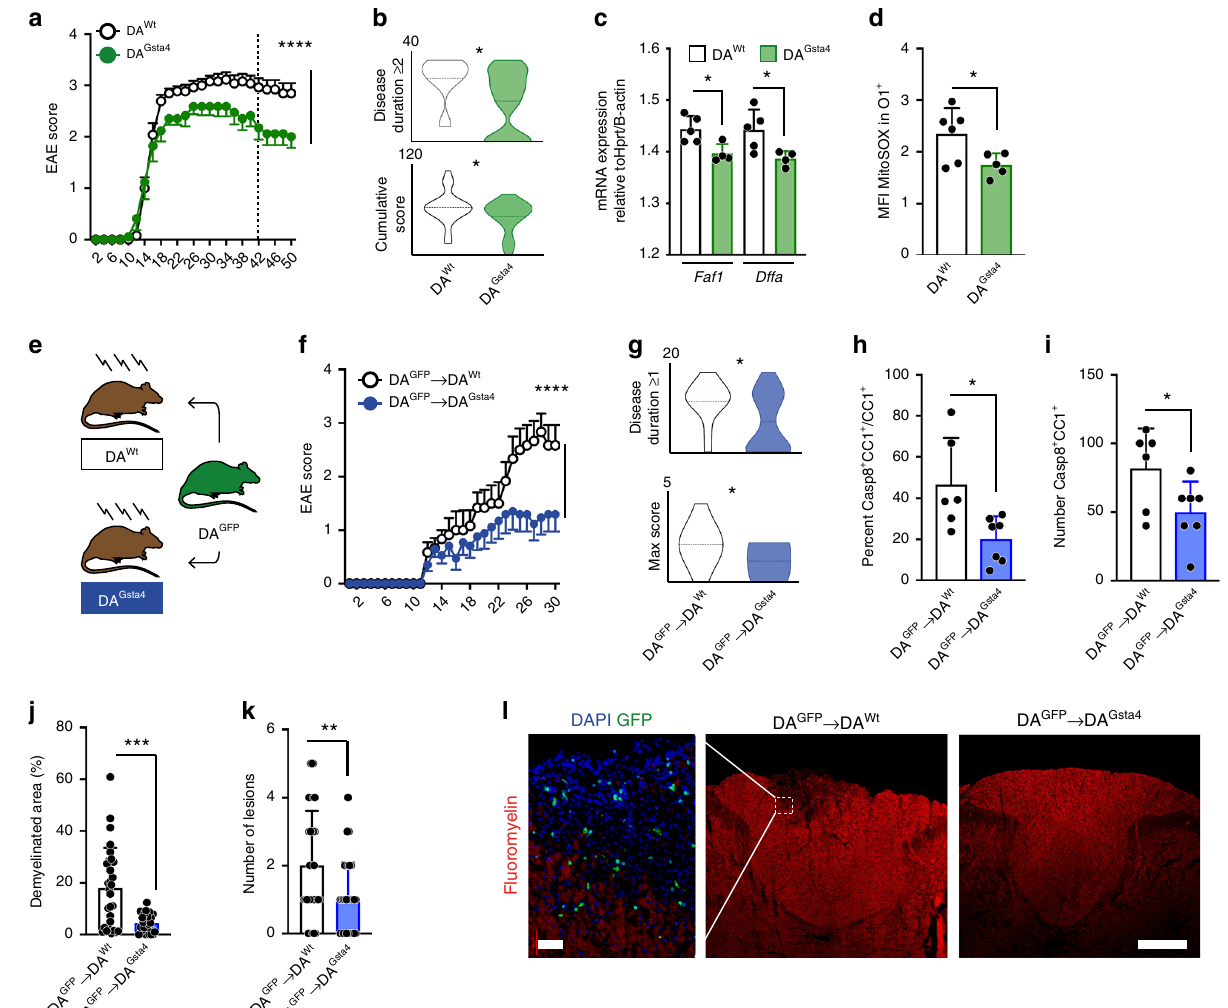
Fig. 6 Gsta4 in CNS ameliorates EAE and reduce demyelinating lesions. a EAE was induced through subcutaneous injection of MOG in adjuvant ( n = 26 + 17). b Disease duration and cumulative score based on a . c mRNA expression of Fas-associated Faf1 and Dffa in spinal cord O4 + OLs at day 30 (dotted line in a ). d Levels of MitoSOX in O1 + OLs from spinal cord at day 50 from a . e , f Illustration of experimental set-up and behavioral EAE score in lethally irradiated DA Wt ( n = 12) and DA Gsta4 ( n = 16) transplanted with DA GFP bone marrow. g Disease duration and max score based on f . h , i Percentage of Casp8 + CC1 + of all CC1 + ( n = 3) and number of Casp8 + CC1 + OLs in spinal cord ( n = 3) at day 30 based on representative animals in e . j , k Demyelinated area of total area of dorsal column and number of dorsal column lesions ( n = 3) at day 30 based on representative animals in e . l Representative images, scale-bar 100 μ m. All data are shown as mean and S.D. apart from b , g showing violin plots and mean. Two-way ANOVA test was used for a , f to analyze differences between groups over-time, graphs are showing mean and S.E.M. Remaining statistical analyses were performed using Student ’ s two-tailed unpaired t test, apart from disease duration and number of lesions analyzed with Mann – Whitney test. * P < 0.05, ** P < 0.01, *** P < 0.001, **** P <